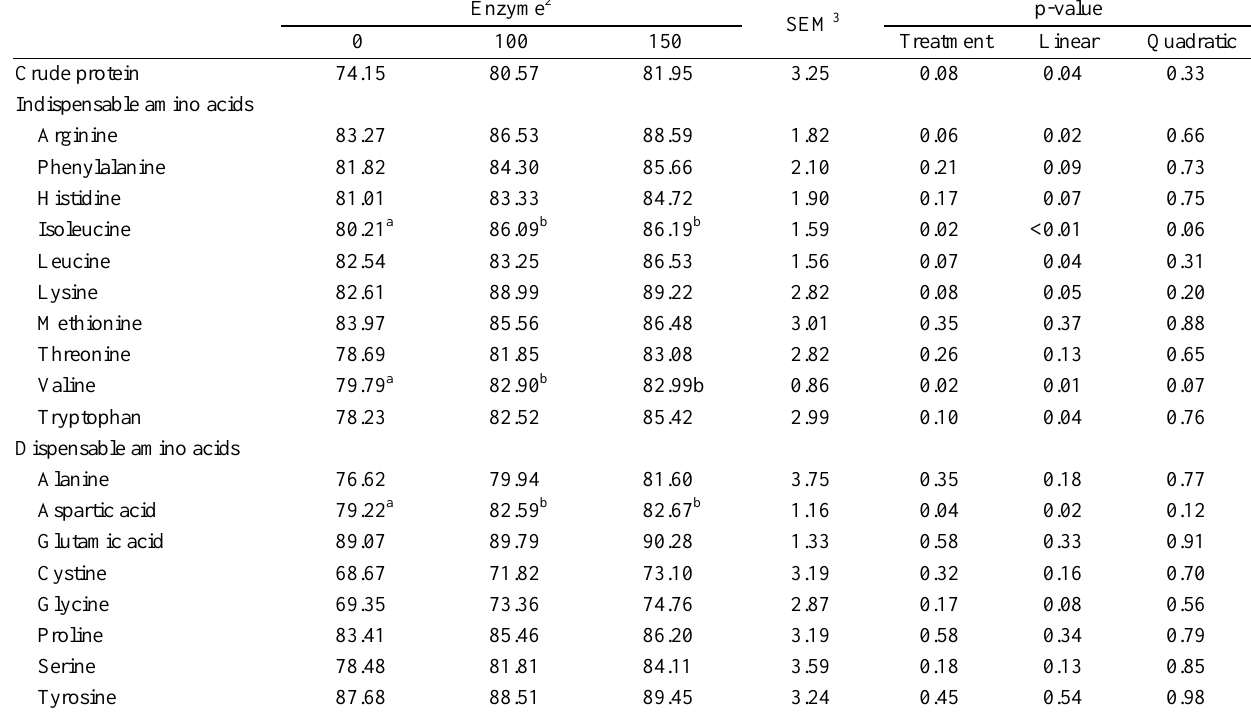
Table 7. Effects of enzyme supplementation on apparent ileal digestibility of amino acids of weaned pigs